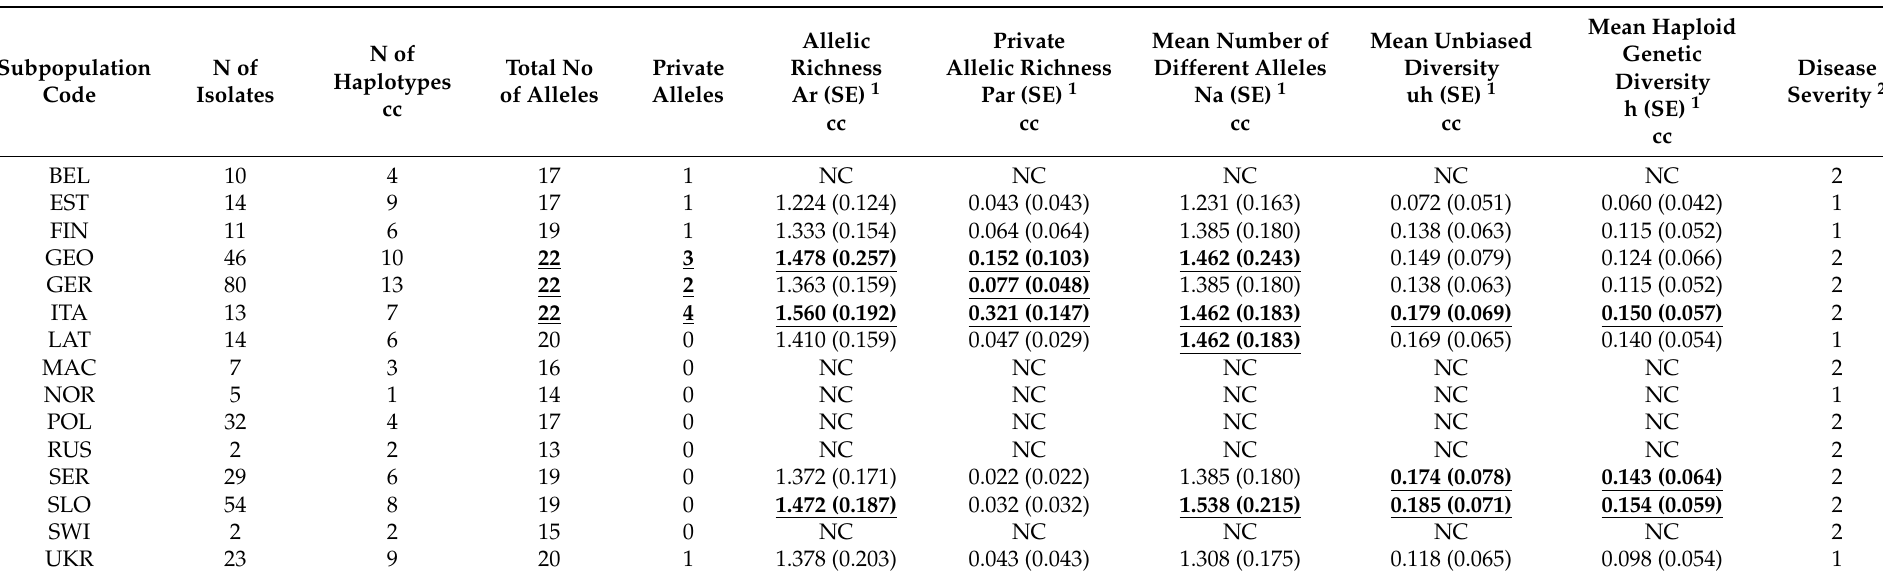
Table 6. Diversity statistics of D. sapinea for the 15 analysed subpopulations using the clone corrected dataset. For each diversity index the three highest values are given in bold and